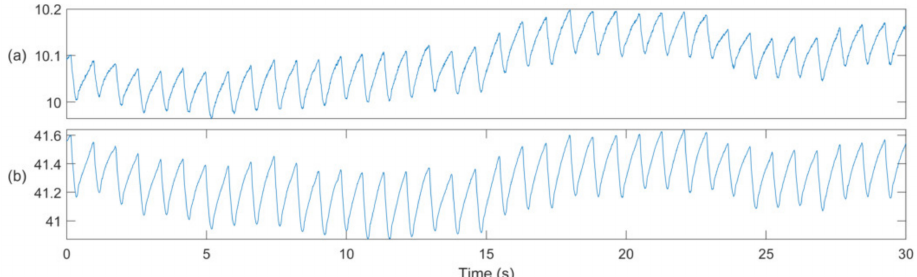
Figure 2. Examples of photoplethysmographic (PPG) signals at ( a ) the red (PPG-R) and ( b ) the infrared wavelength (PPG-IR). Note that the amplitude of these signals is in arbitrary